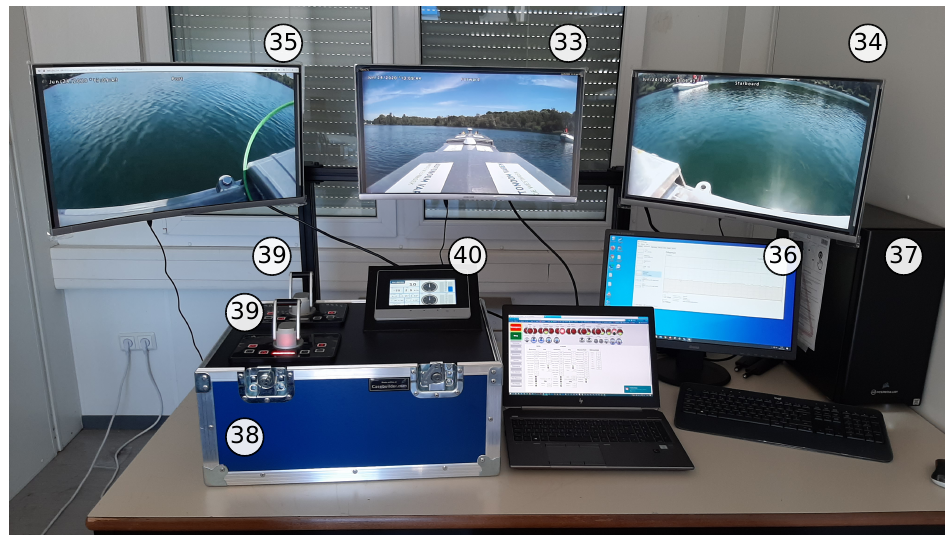
Figure 9. Constructed I-SCC streaming video data from the USV sailing on the Rotselaar lake (see Section 5.1), part numbers refer to Table A1.